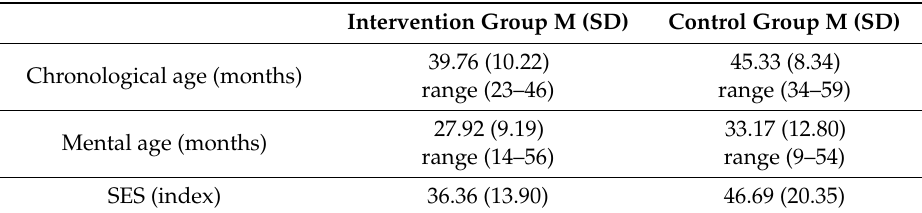
Table 1. Demographic